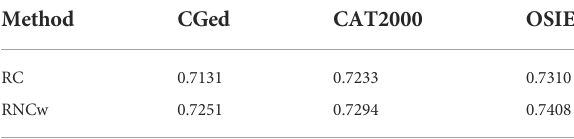
TABLE 2 The ROC areas on three eye-tracking